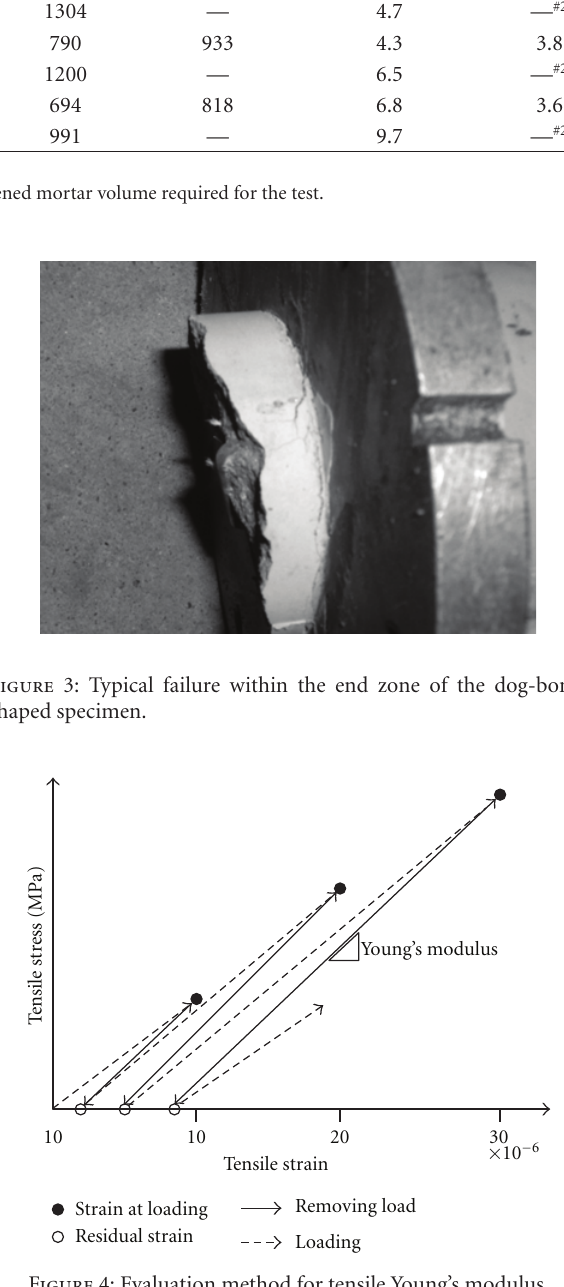
Figure 4: Evaluation method for tensile Young’s